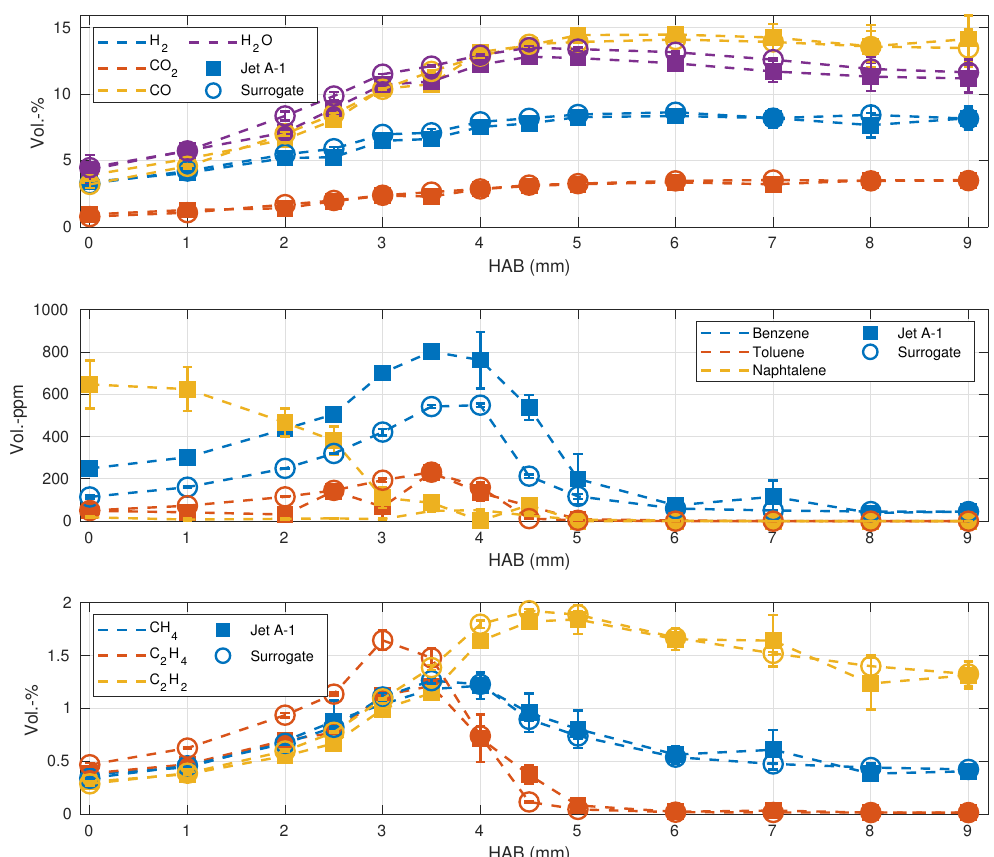
Figure 5. Species concentration profiles measured by GC/MS at Φ = 2.1 and 5 cm/s inlet